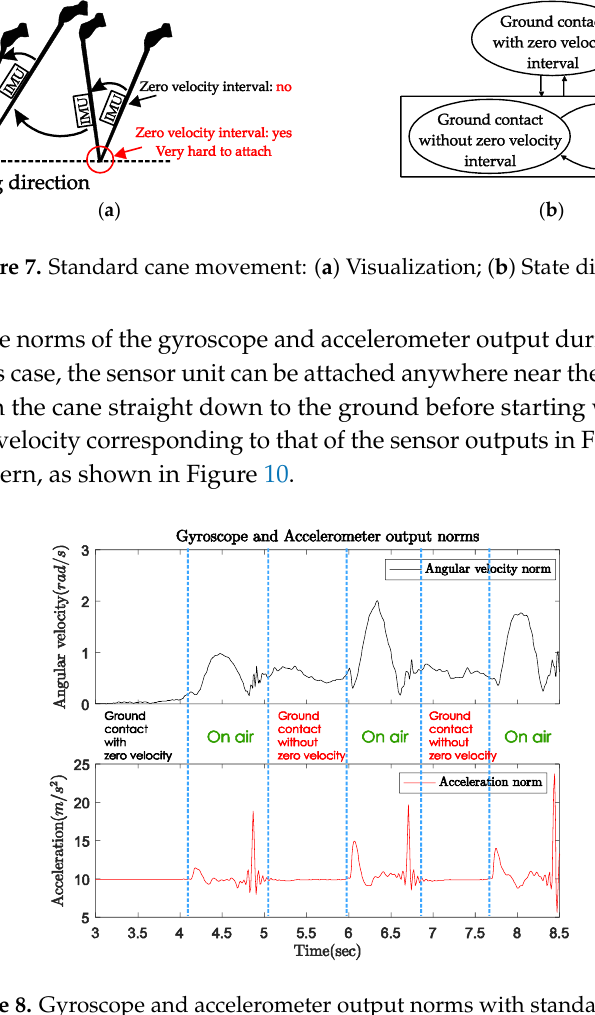
Figure 8. Gyroscope and accelerometer output norms with standard cane.